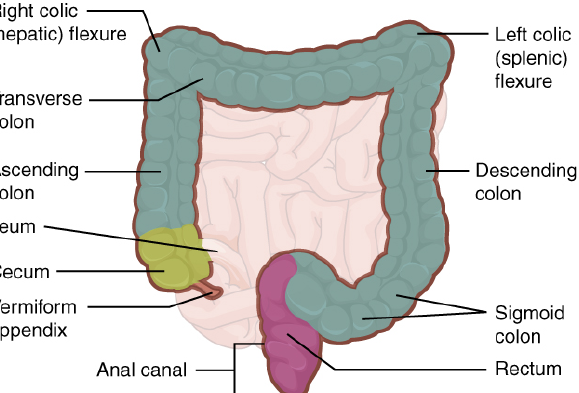
Figure 1. Illustration of the large intestine. Taken from Anatomy and Physiology , OpenStax (Licensed: